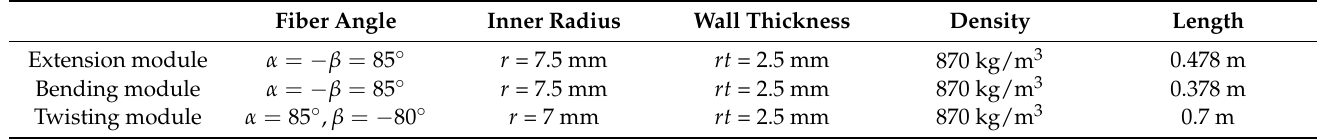
Table 1. Detailed configuration of soft actuators.